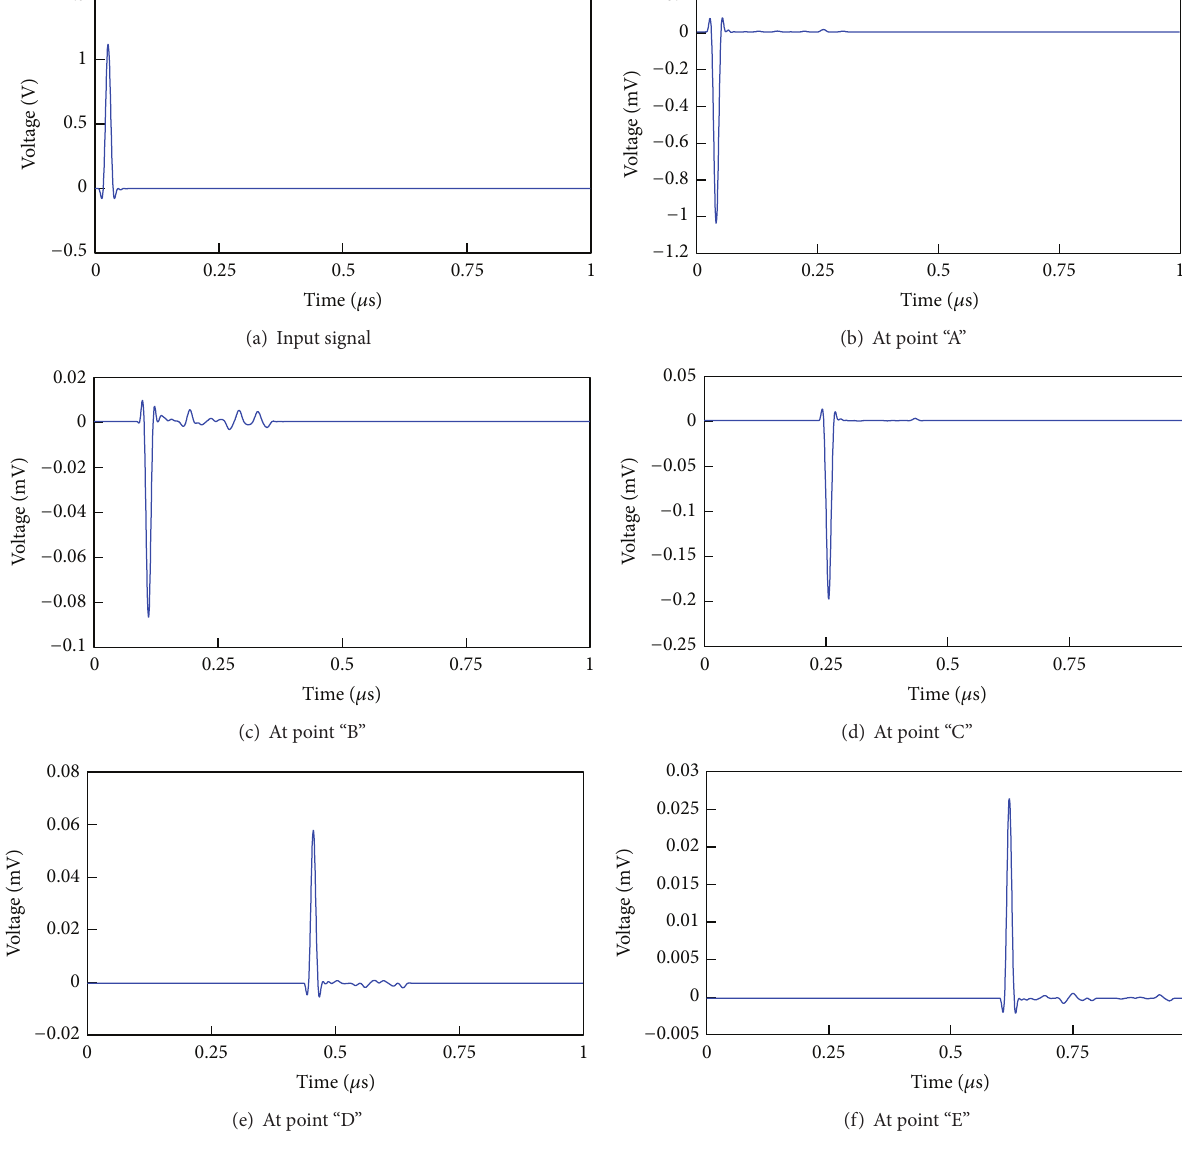
Figure 5: Demodulated baseband signals of a curved tunnel obtained by the